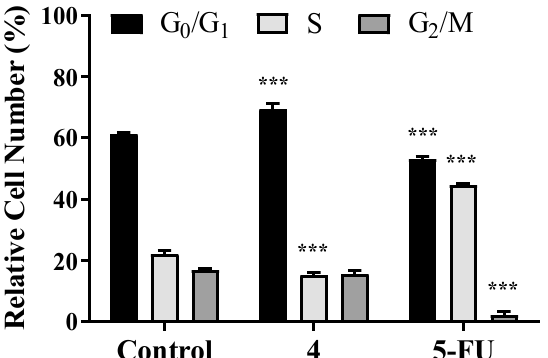
Figure 6. HepaRG cycle distribution after treatment with compound 4 (at 50 µM) for 24 h. 5-Fluorouracil ((5-FU), 50 µM) was used as positive control and untreated cells as a negative control. Each bar represents the mean ± SD (originating from two independent experiments). *** p < 0.001 vs. control (two-way ANOVA post-hoc Bonferroni test).